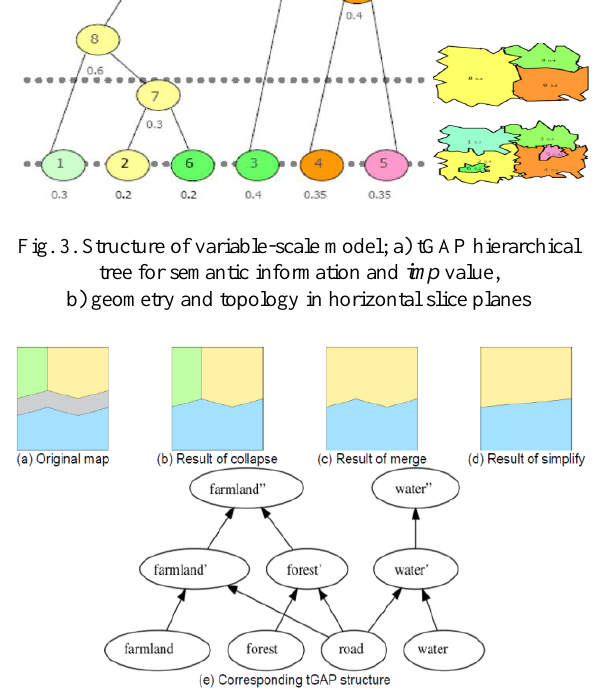
Fig. 4. The process of generalization and hierarchical tGAP structure (Oosterom and Meijers,